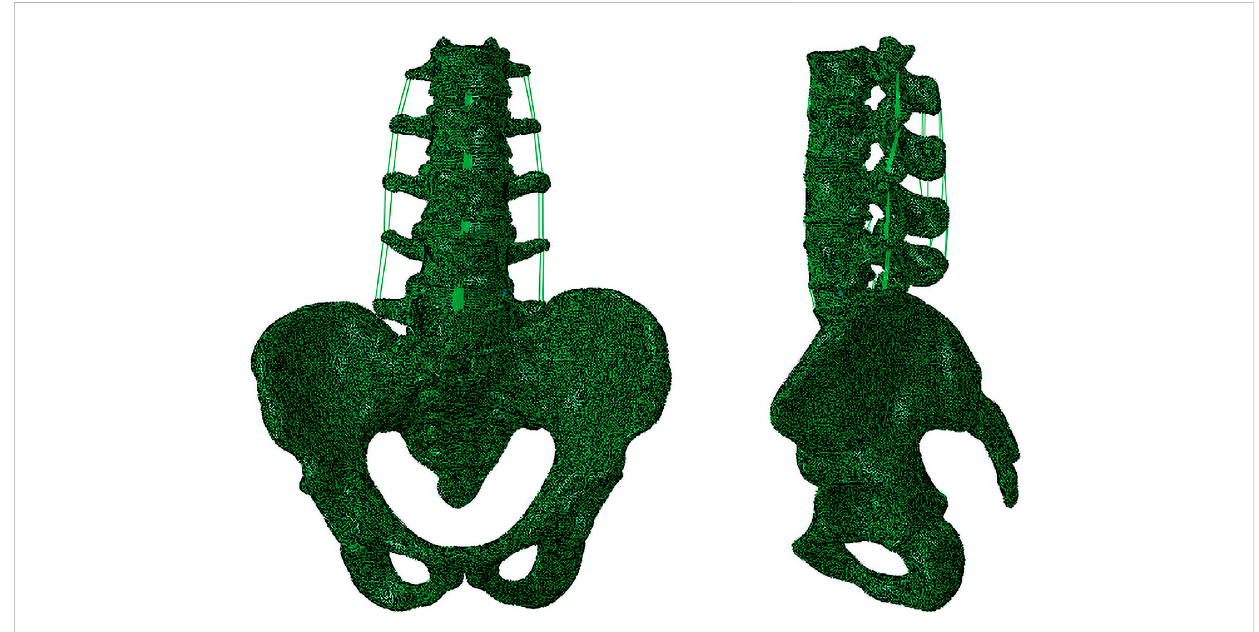
FIGURE 1 The intact lumbopelvic fi nite element